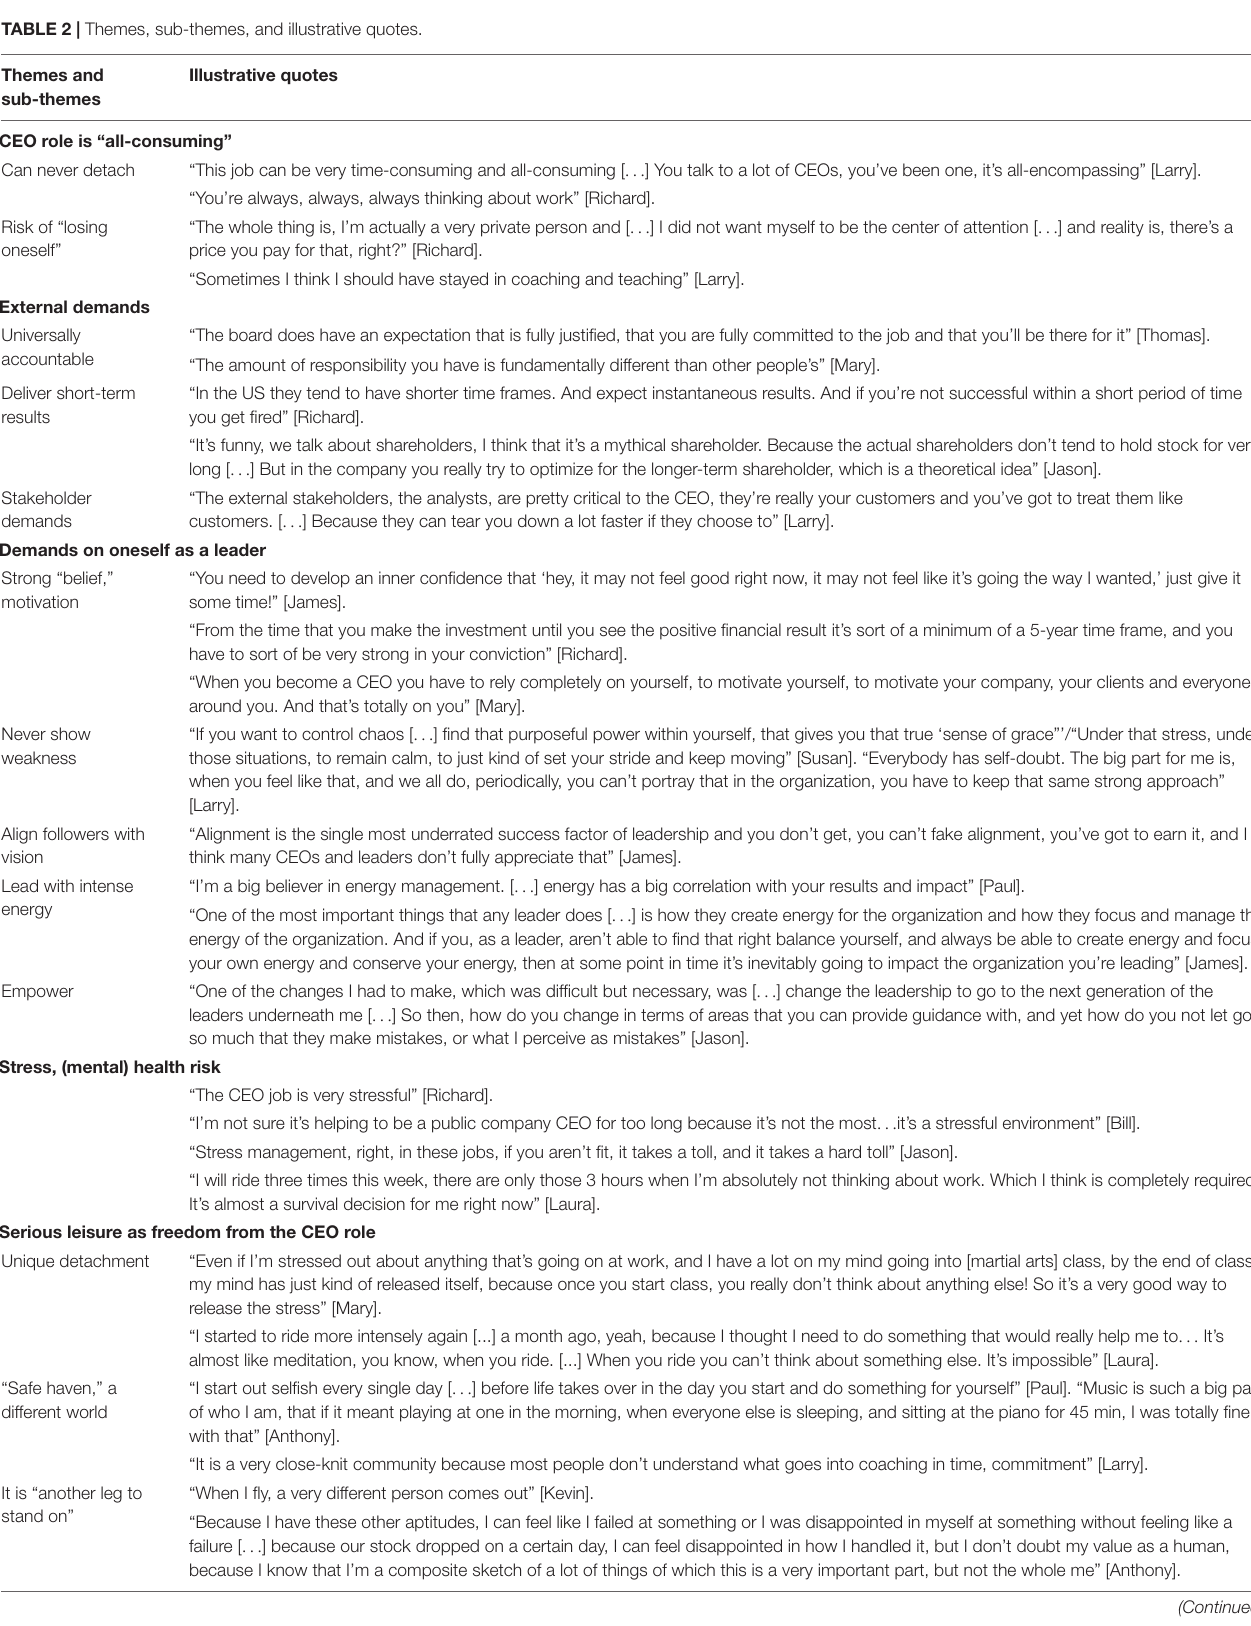
TABLE 2 | Themes, sub-themes, and illustrative quotes. Themes and Illustrative sub-themes